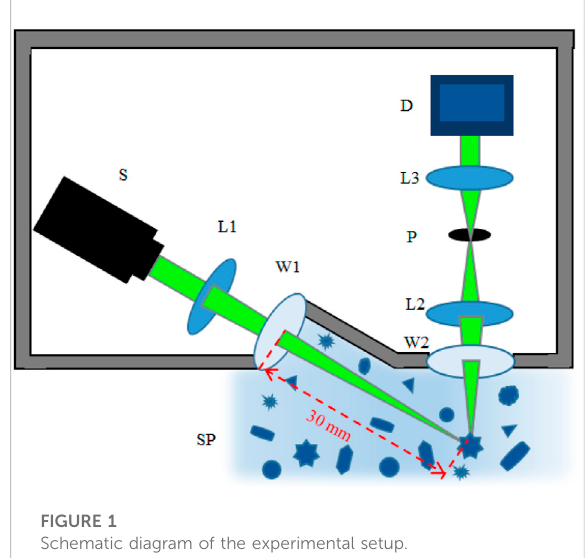
FIGURE 1 Schematic diagram of the experimental